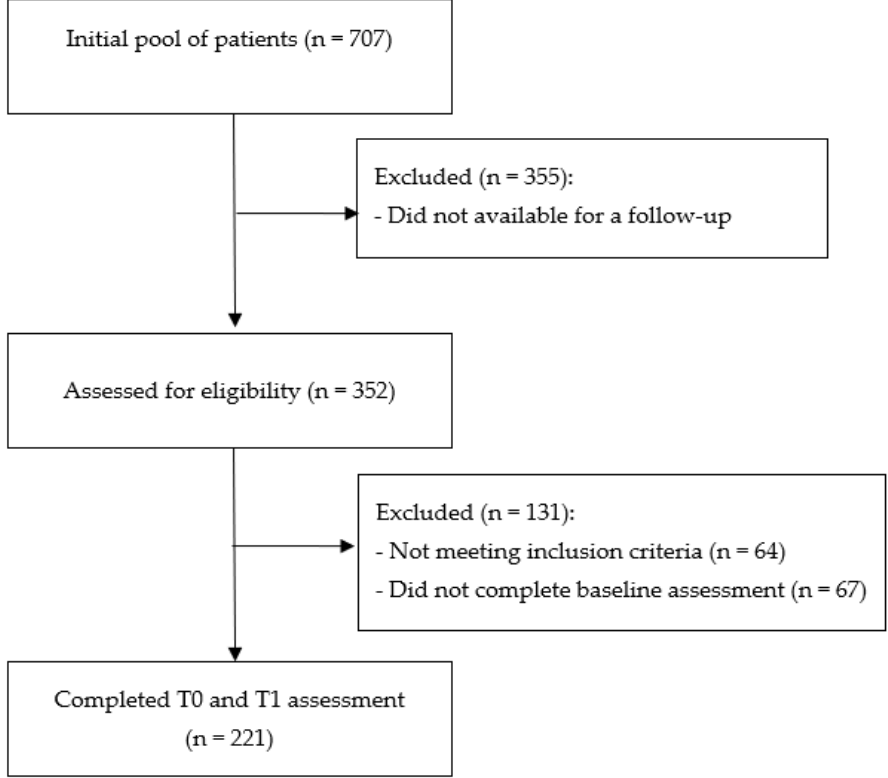
Figure 1. Consort diagram describing the flow of participation in the study.